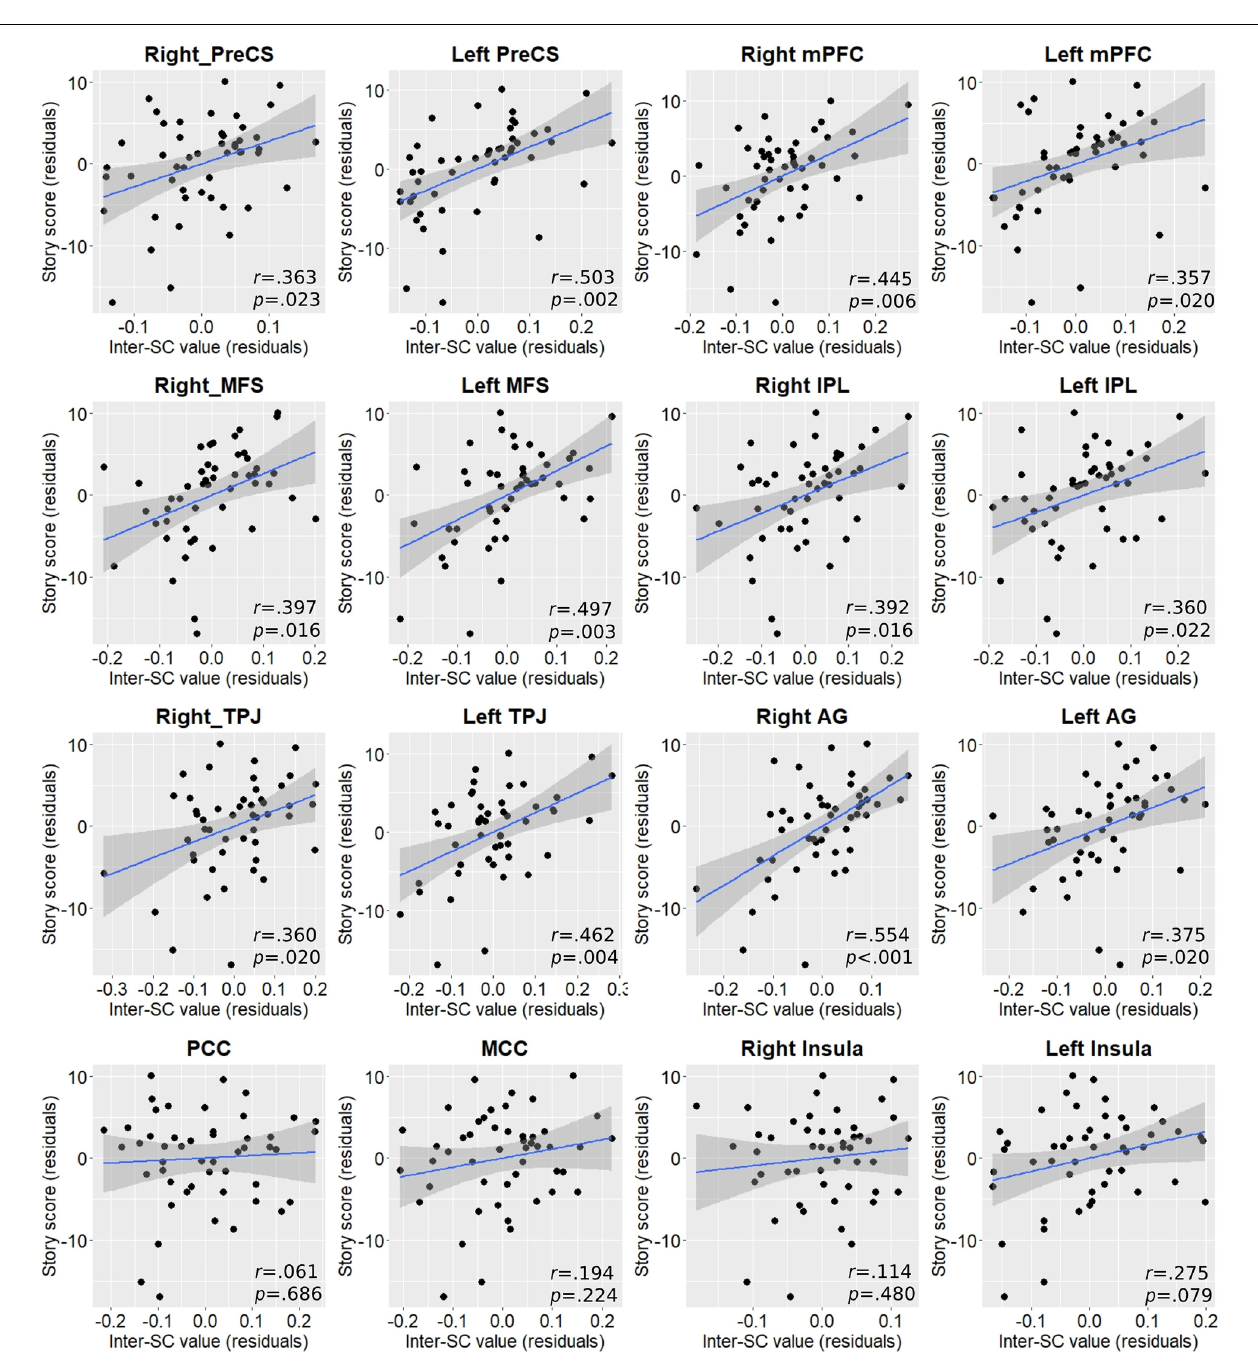
FIGURE 4 | Partial correlation plots between inter-SC values and post-scan story score in regions exhibiting between-group differences. P-values are FDR-corrected for multiple comparisons. AG, angular gyrus; IPL, inferior parietal lobule; MCC, middle cingulate cortex; MFS, middle frontal sulcus; mPFC, medial prefrontal cortex; PCC, posterior cingulate cortex; PreCS, precentral sulcus; TPJ, temporoparietal